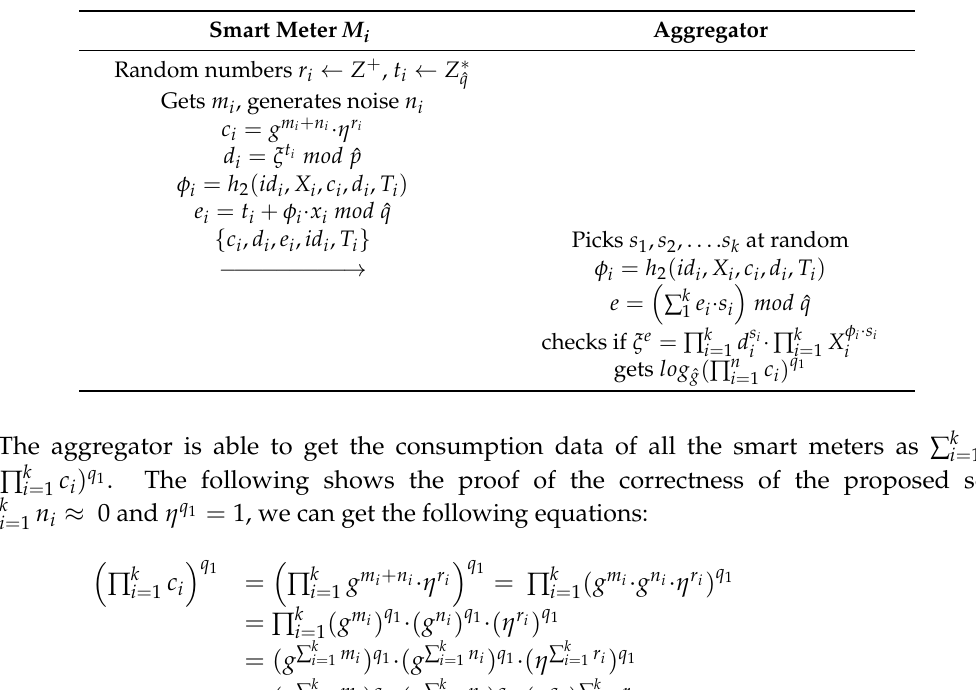
Table 6. Proposed aggregation